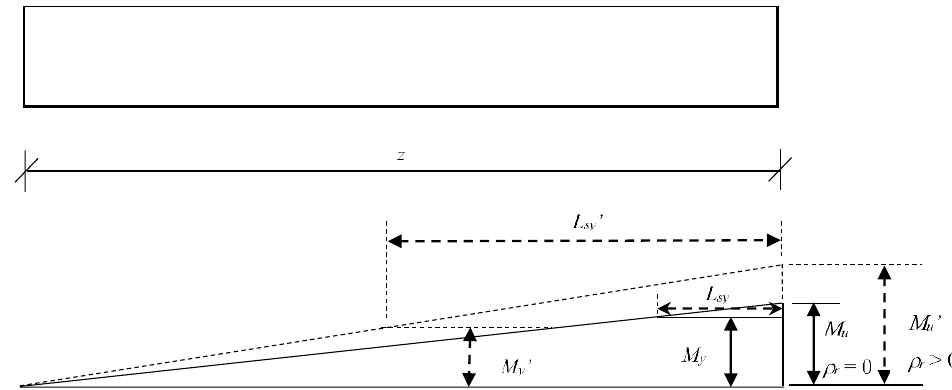
Figure 5. Longitudinal steel strain distribution: ( a )  r = 0; ( b )  r = 0.33; ( c )  r = 1; ( d )  r = 3.